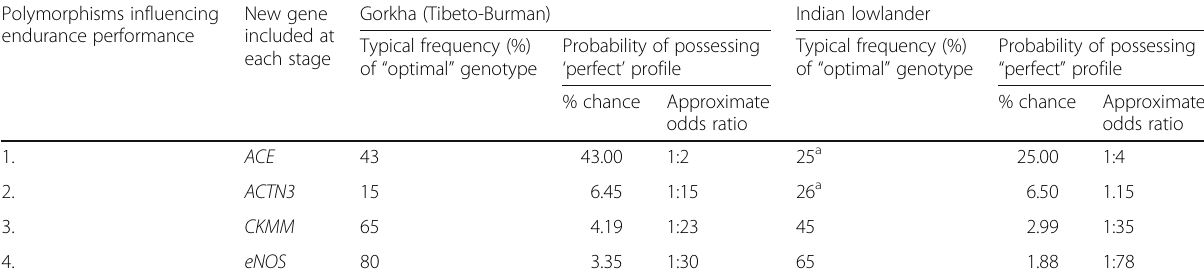
Table 7 Probability of possessing “ optimal ” genetic profile by number of polymorphism in the male Gorkha (TB) and Indian lowlander (IA) soldiers Polymorphisms influencing endurance